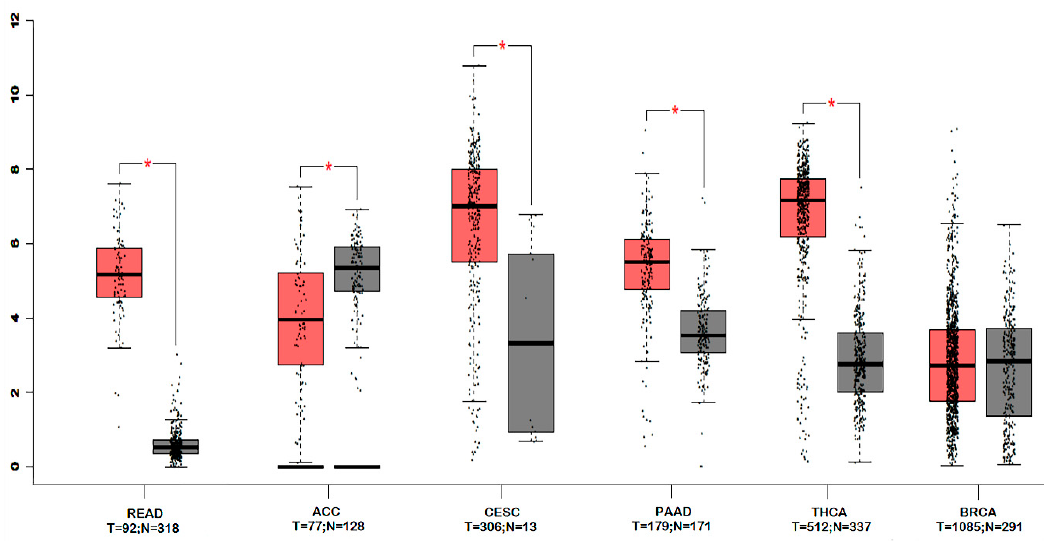
Figure 5. Boxplot showing the distribution of CLDN-1 expression in tumors and normal tissues for different types of cancers. Significant differences are shown with an asterisk (*). Boxplots were generated using GEPIA1 webserver and p -value < 0.01 was considered as significant.